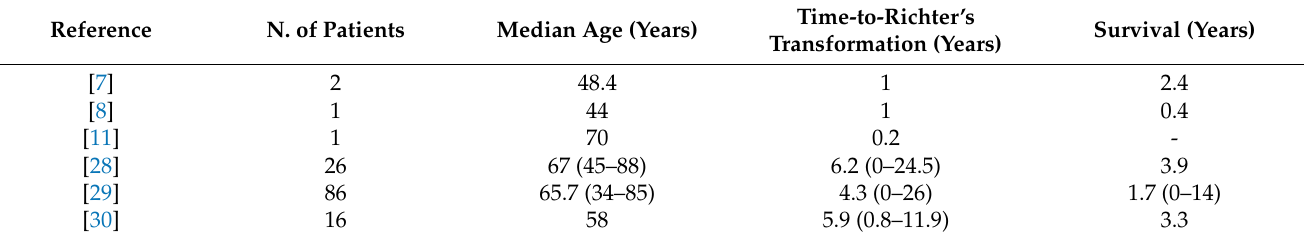
Table 1. Reported cases of HL-transformed